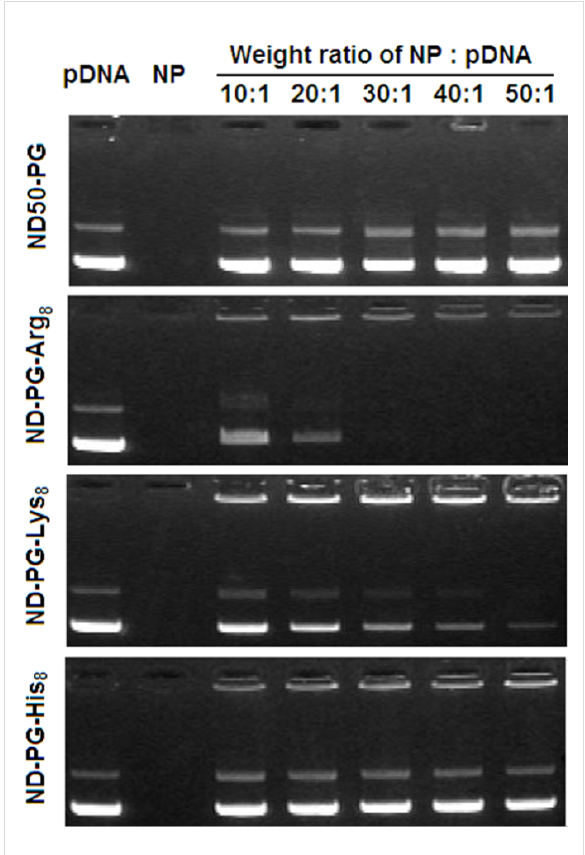
Figure 6: Electrophoretic migration of pDNA, NP (ND50-PG or ND-PG-BPP), and NP/pDNA mixtures at various weight ratios.